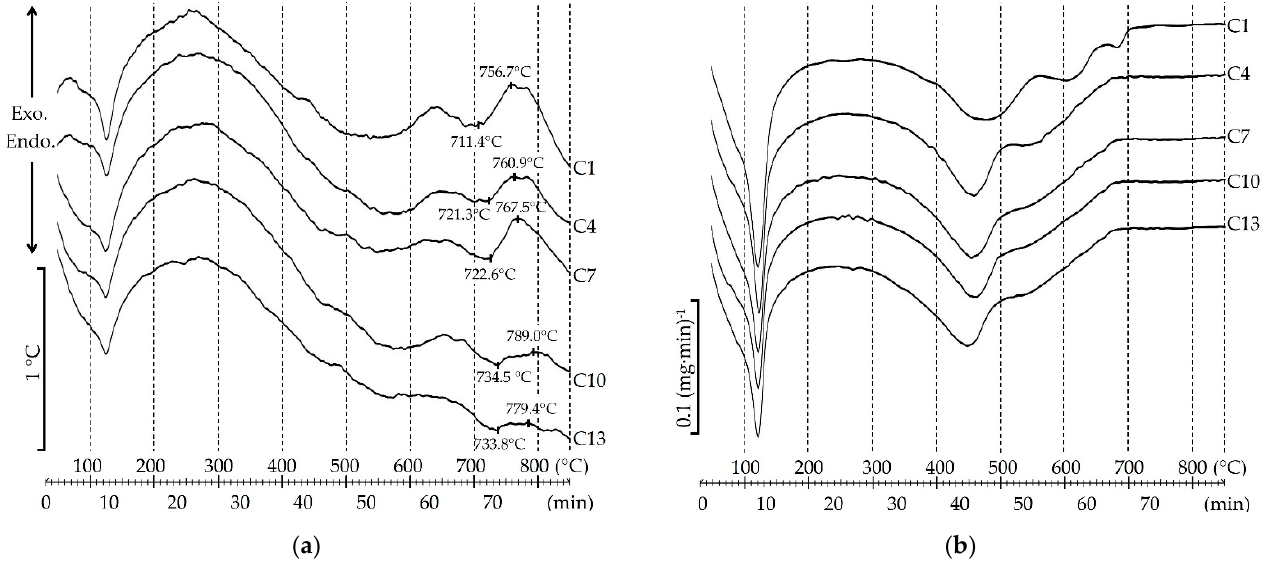
Figure 1. DTA ( a ) and DTG ( b ) curves of charge mixture samples.